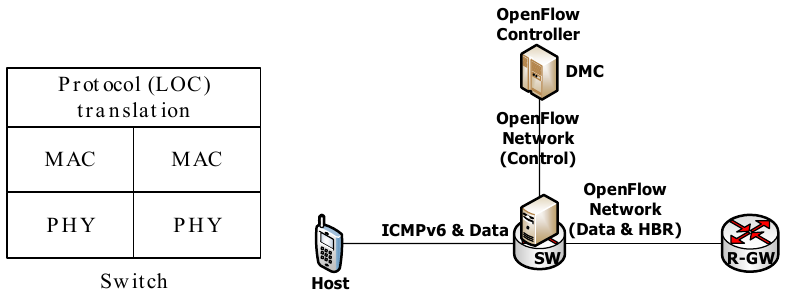
Figure 15. Protocol stack of the switch (SW) and connection with other entities.